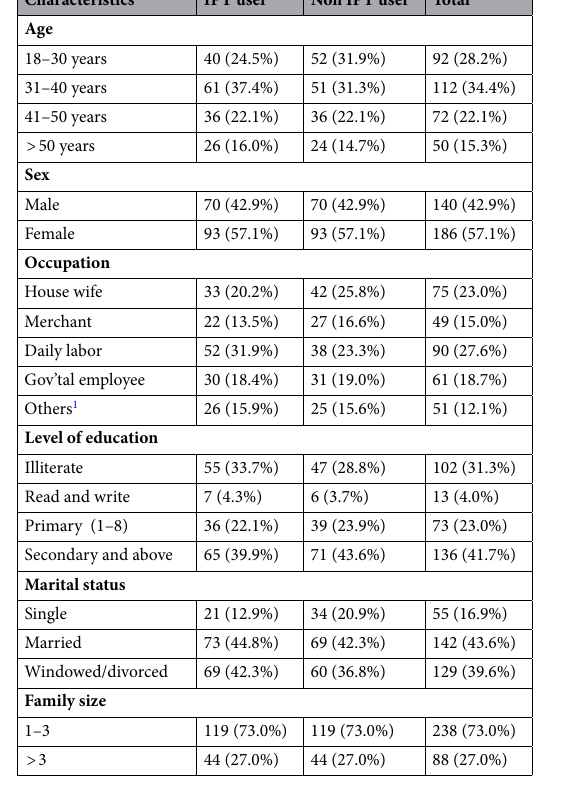
Table 1. Socio-demographic characteristics of respondents by category of PLHIV Dessie city administrative